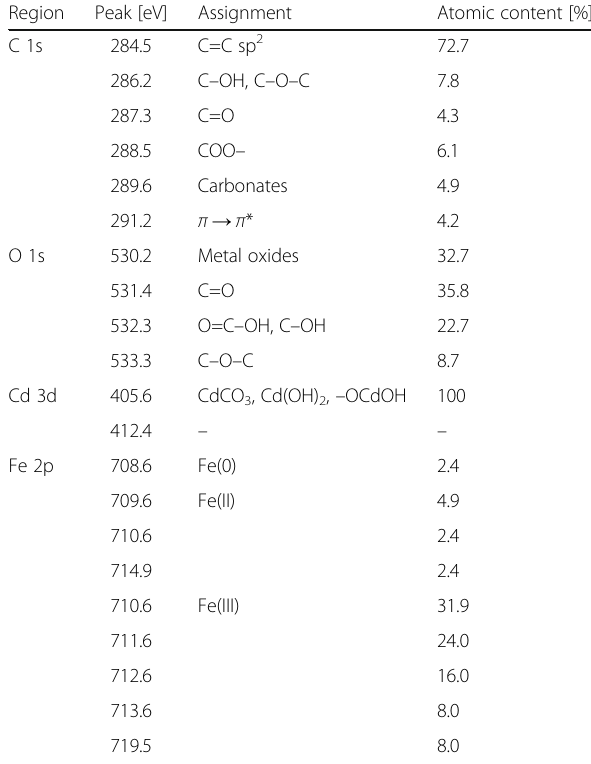
Table 6 Fitted C 1s, O 1s, Cd 3d, and Fe 2p peak parameters deduced from the XPS analysis for MBC2 after the Cd(II) ion sorption